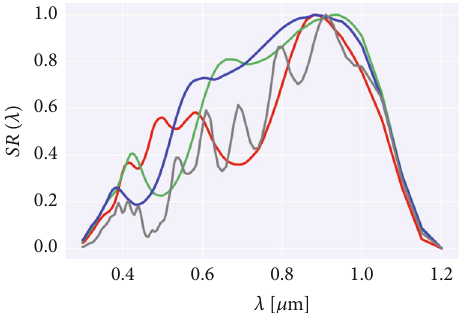
Figure 2: Illustration of the relative spectral response SR ð λ Þ evaluated for four colored solar cells from [5]. The curve color corresponds to the cell color except the white cell for which SR ð λ Þ is displayed in